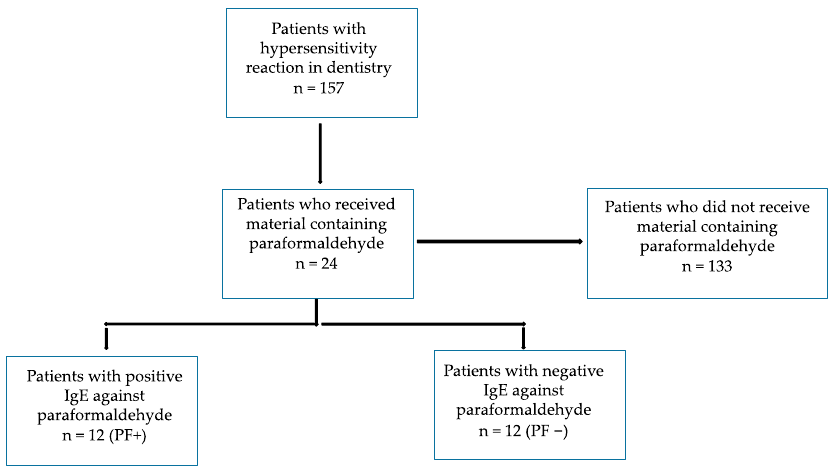
Figure 1. Flow chart of recruited cases. The specific IgE against paraformaldehyde ranged between 0.5 and 100 kU/L, median was 2.31, and interquartile range was 0.9–2.35 kU/L. Two (16.7%) results were within class 1, four (33.3%) within class 2, three within class 3 (25%), two (16.7%) within class 4, and one (8.3%) within class 6 (Figure